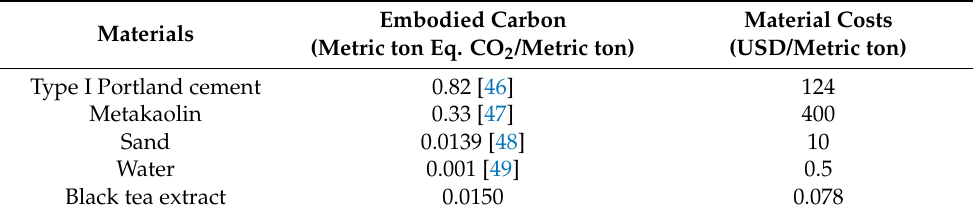
Table 5. Embodied carbon and material costs of raw